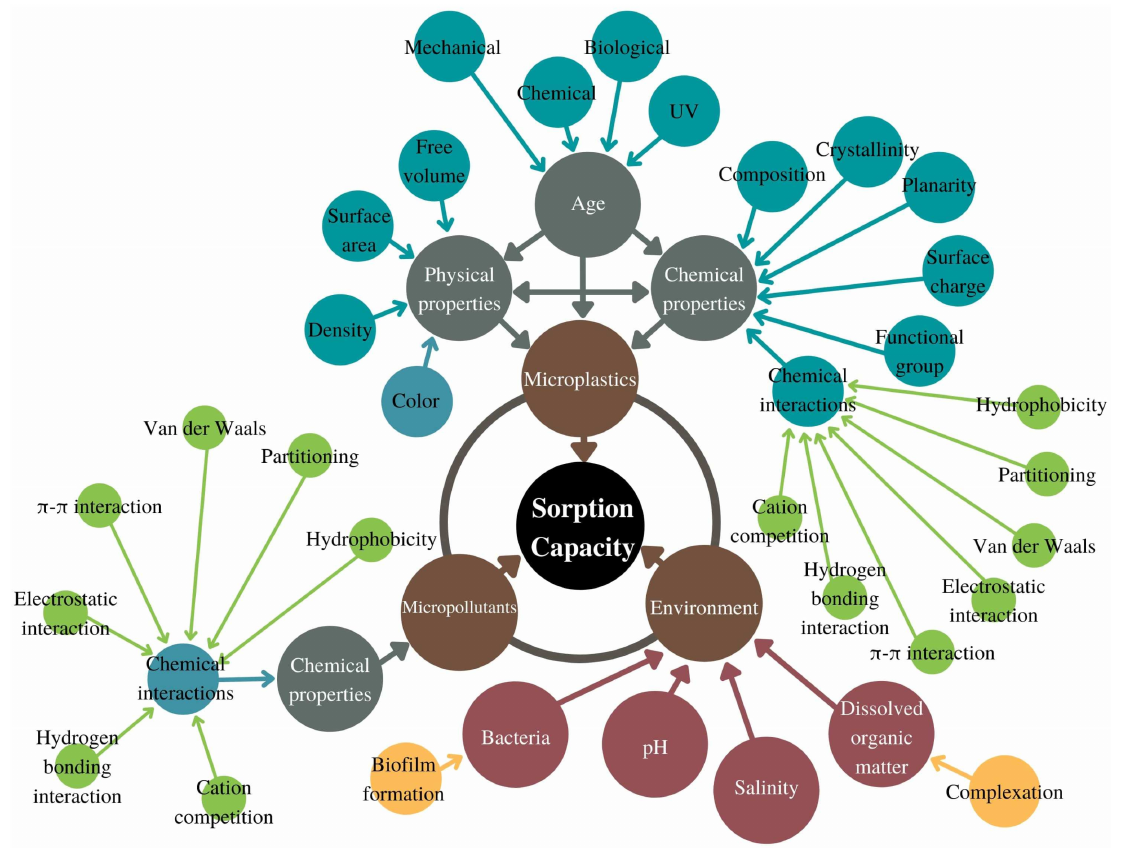
Figure 1. Major factors and sub-factors influencing the sorption capacity of microplastics to